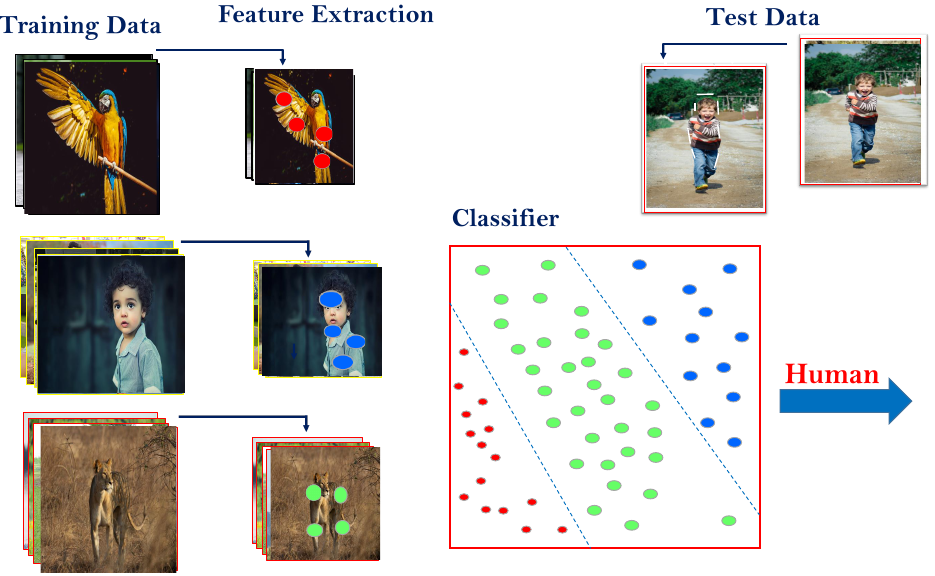
Figure 1. Example of machine learning work flow for object classification across three different classes (bird, human, and